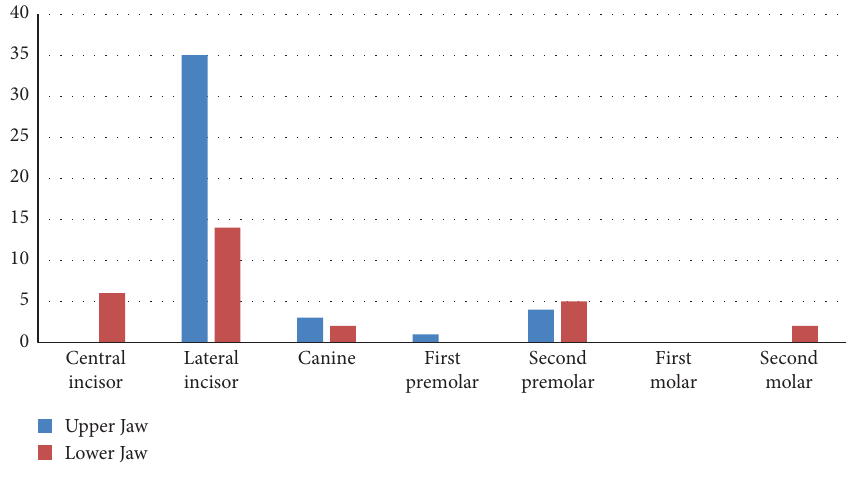
Figure 2: Distribution of the number of missing teeth in the upper and lower jaw. Table 2: Distribution of patients with hypodontia among the three classes of malocclusion. Malocclusions